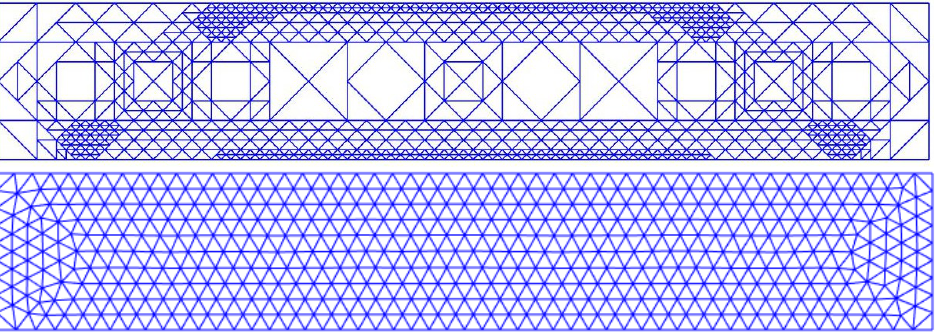
Figure 16. Part with optimised infill design ( top ) and uniform infill design ( bottom